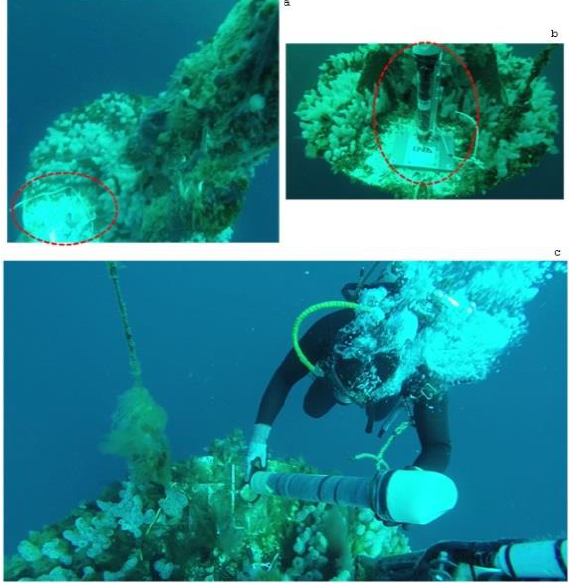
Figure 3. ADCP installation on the buoy. Assembly on the buoy damping disk: ( a ) overall view; ( b ) detail view; ( c ) re-installation of the ADCP on the mounting system following the battery replacement.